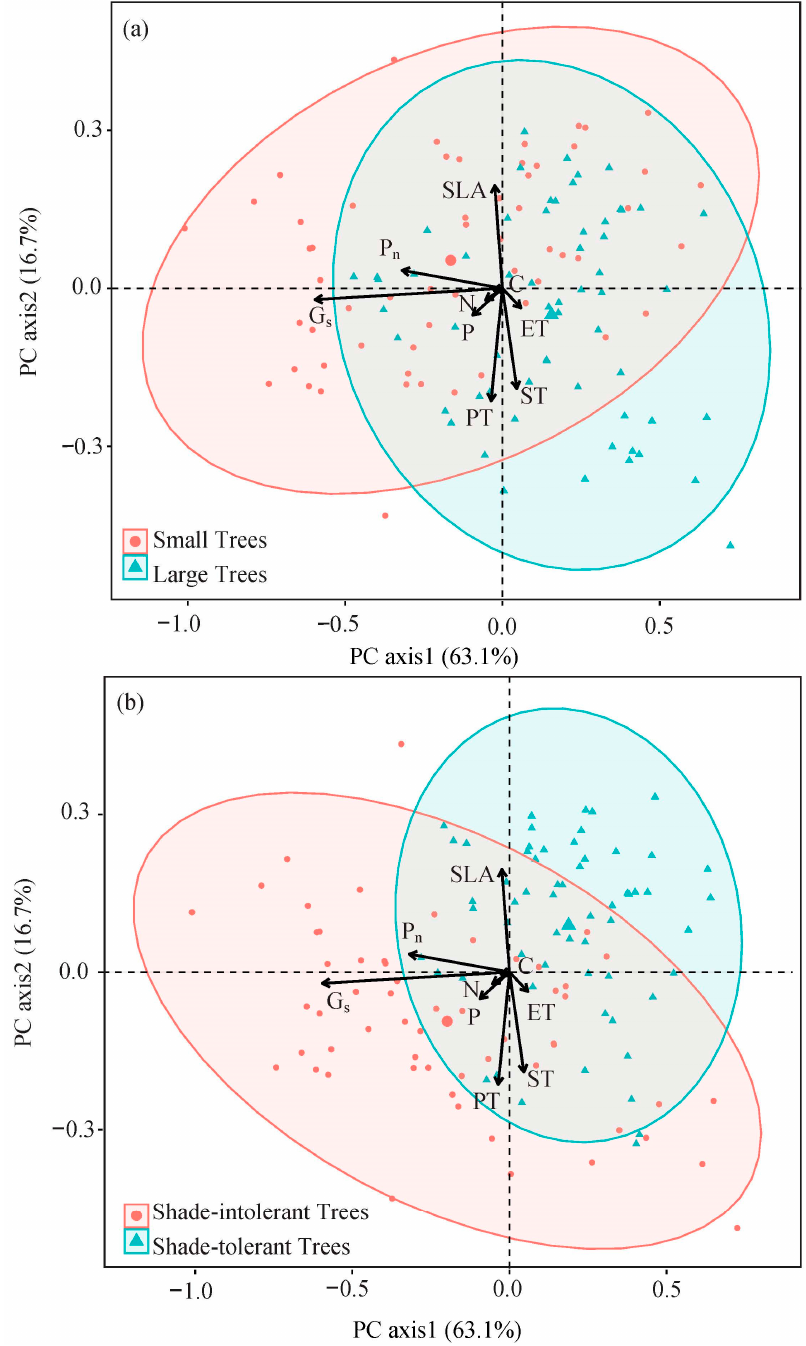
Figure 1. Principal component analysis of 8 leaf traits of different tree sizes or shade-tolerances. The meanings of abbreviations are shown in Table 2. ( a ) Distribution of trees of different sizes with respect to leaf traits; ( b ) Distribution of different shade tolerance trees with leaf traits.